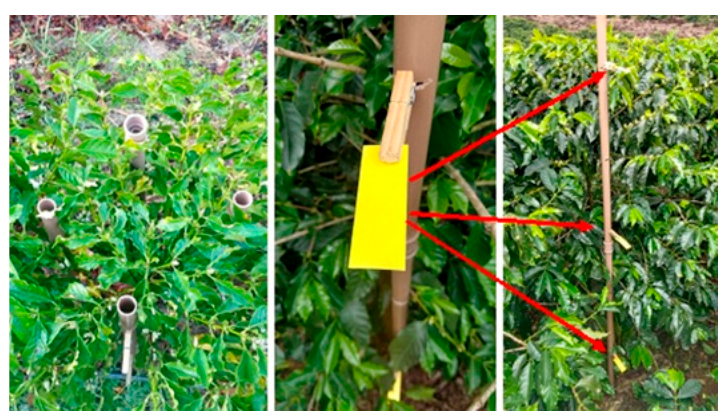
Figure 4. Arrangement of water-sensitive paper tags using PVC templates.